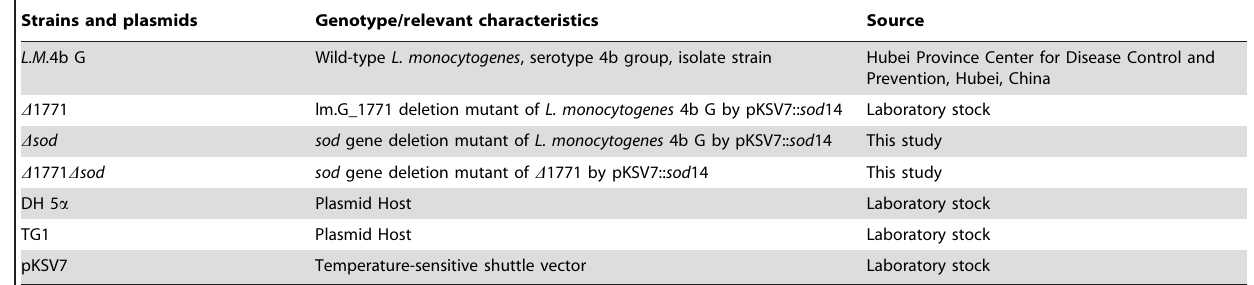
Table 1. Strains and plasmids used in this study.